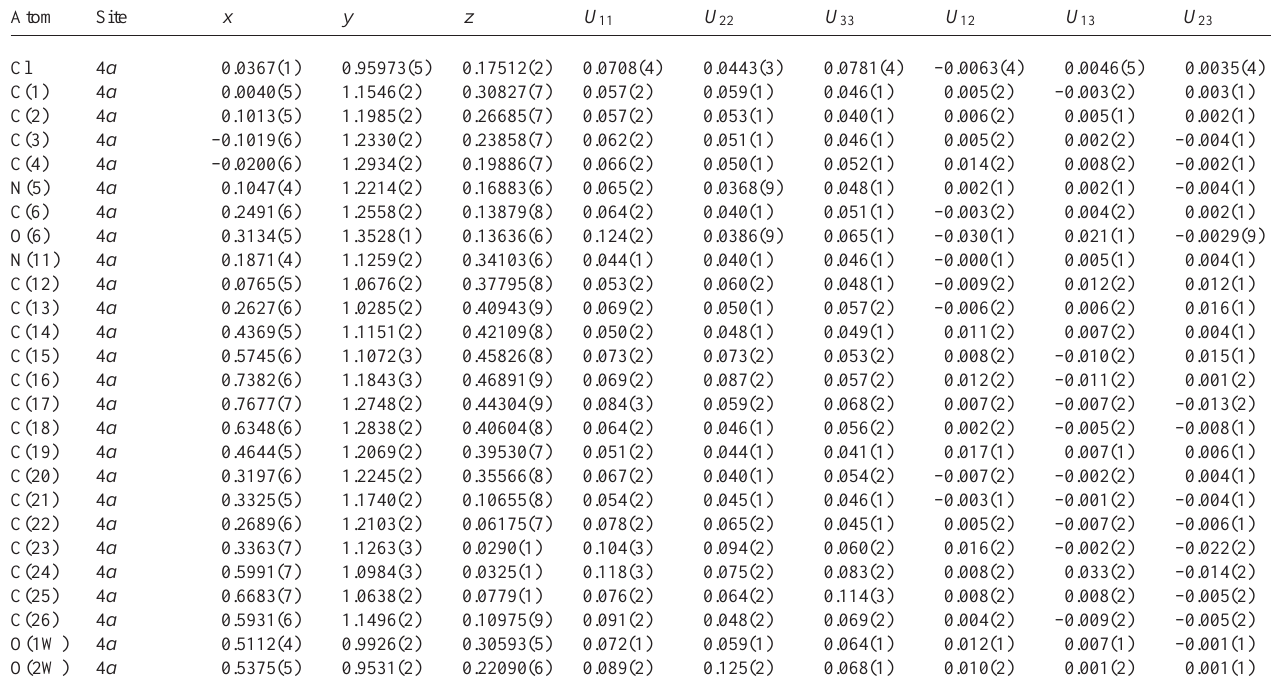
Table 3. Atomic coordinates and displacement parameters (in Å 2 )